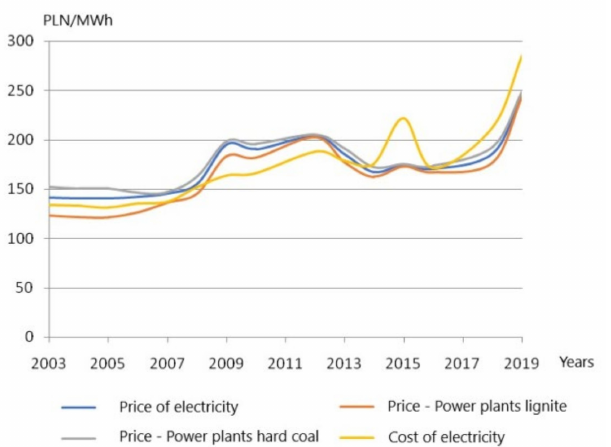
Figure 1. Price of electricity on HRE and cost of electricity in PLN/MWh (Source: own work based on data from